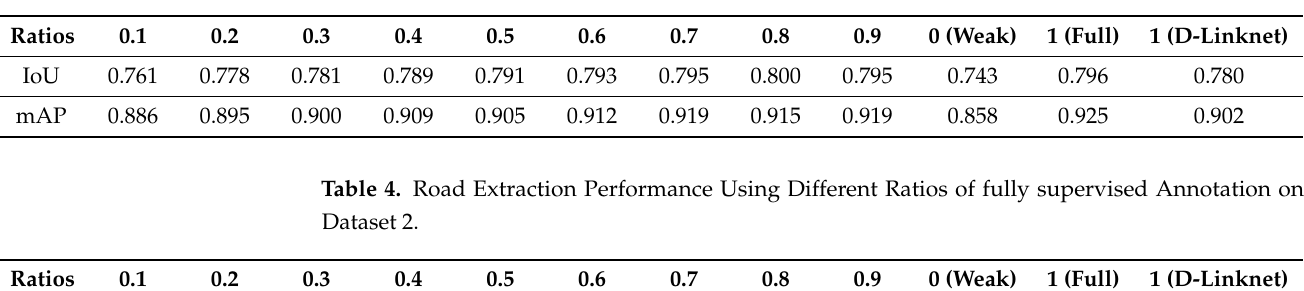
Table 3. Road Extraction Performance Using Different Ratios of fully supervised Annotation on Dataset 1.